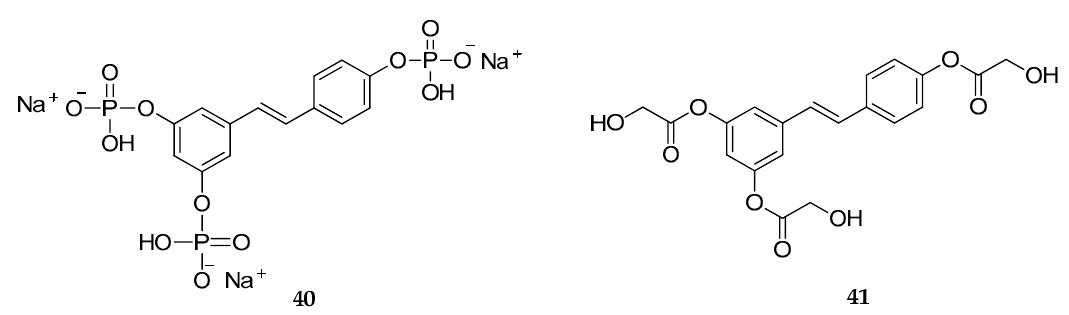
Figure 15. Chemical structures of RSV triphosphate ( 40 ) and RSV triglycolate ( 41 ).